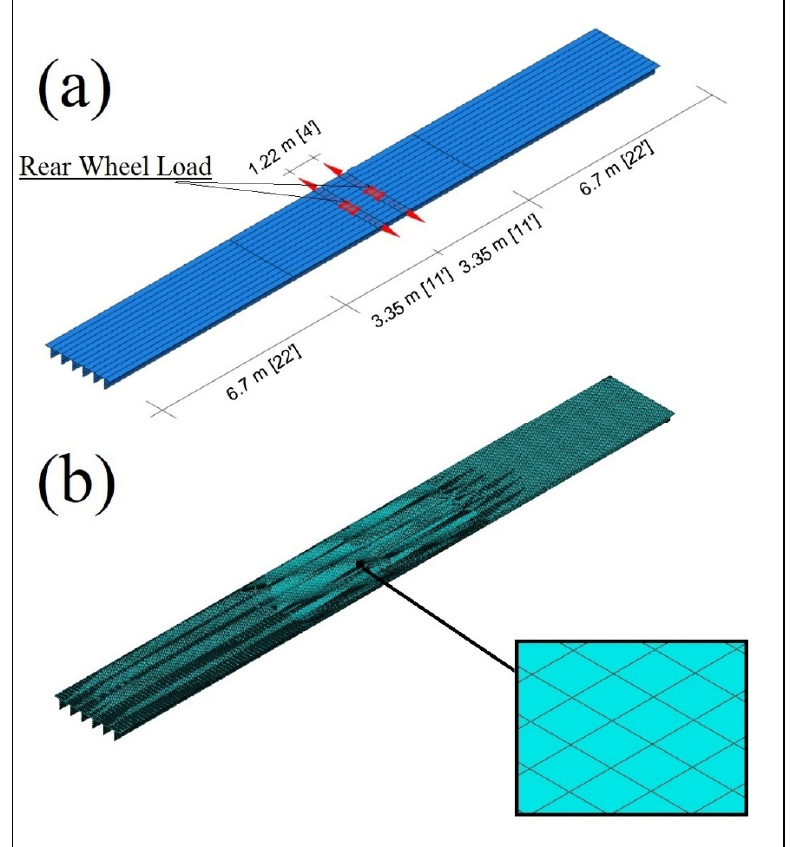
Figure 7. Three-span bulb section shell simulation: ( a ) rear load assembly and dimensions; ( b ) shell element mesh.